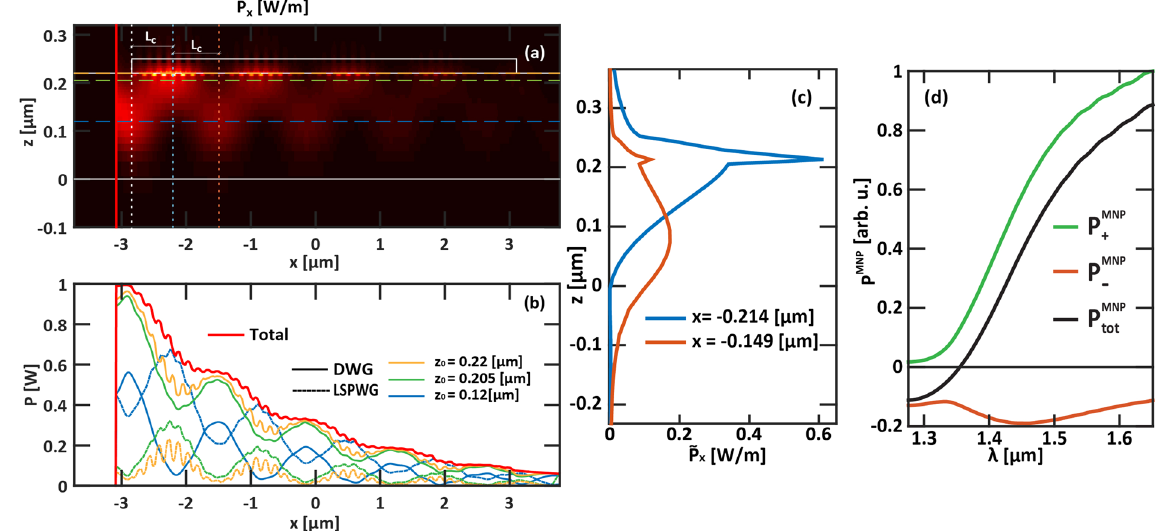
∼ Figure 4. ( a ) P x , defined in Eq. (2), as a function of the x- and the z-coordinates when λ = 1.450 μ m . The superimposed white solid thin lines represent the structure contours, whereas the white, light blue and orange thin dotted vertical lines represent x = x 0 , x = x 0 + L c and x = x 0 + 2 L c , respectively. The superimposed horizontal orange, green and light blue thin dashed lines represent the integration limit z 0 = 0.22, 0.205 and 0.12 μ m , respectively. ( b ) Integrated power, flowing in the DWG (solid curves) and in the LSPWG (dashed curves), as a function of the x -coordinate, when the integration limit is assumed equal to z 0 = 0.22 (yellow curves), 0.205 (green curves) and 0.12 μ m (blue curves). The red solid curve represents the total power as a function of the ∼ x-coordinate. ( c ) z -profiles of P , x integrated over one period along the x-direction, centered at x = x 0 + L c (blue solid curve) and x = x 0 + 2 L c (orange solid curve). ( d ) Positive (green curve), negative (orange curve) and total (black curve) part of the Poynting vector, integrated in the hemispace above the MNPs